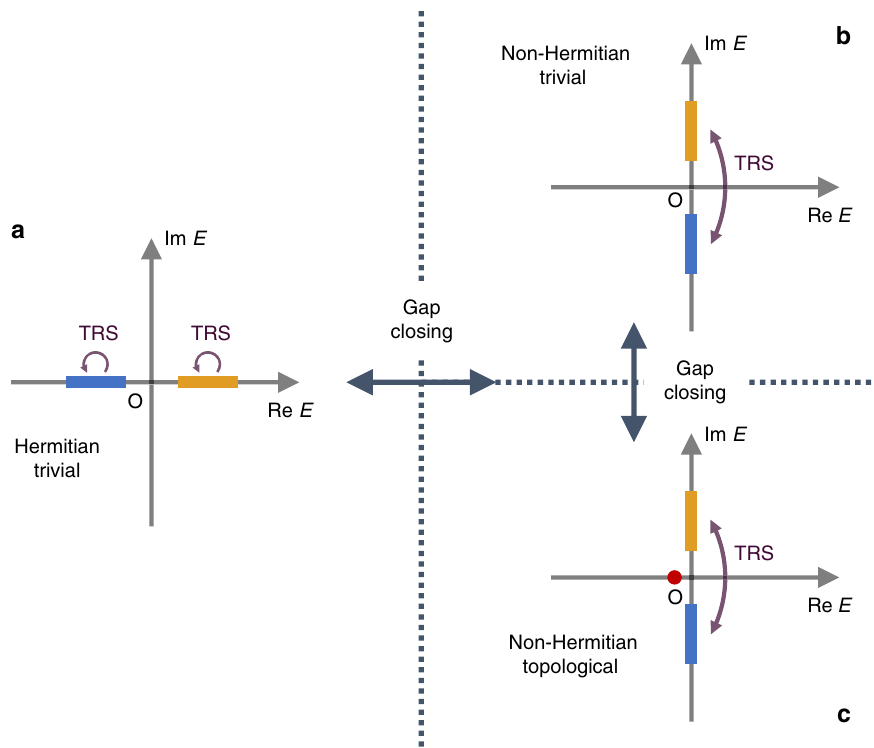
Fig. 4 Complex-band structure of non-Hermitian one-dimensional insulators with time-reversal symmetry (1D class AI). Blue and yellow bands represent complex bands and red dots represent topologically protected edge states. a Hermitian gapped band structure. All the bands individually respect time- reversal symmetry, and topological phases are absent. b , c Non-Hermitian gapped band structure in 1D class AI for b the trivial phase and c the topological phase. Two bands are paired via time-reversal symmetry and the complex-gap closing associated with a topological phase transition should occur between ( a ) and ( b , c